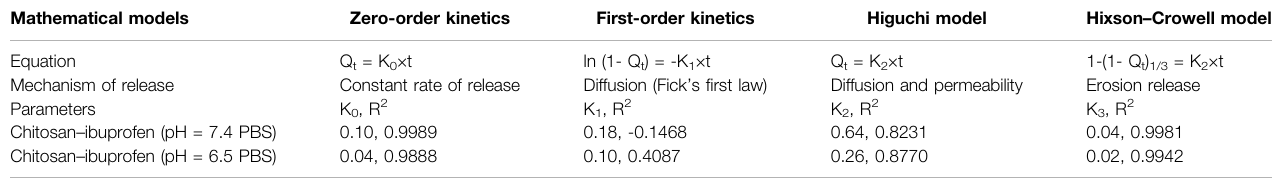
TABLE 1 | Permeation parameters and release mechanisms of ibuprofen from chitosan – ibuprofen aerogels derived from different mathematical models of drug release kinetics. Mathematical